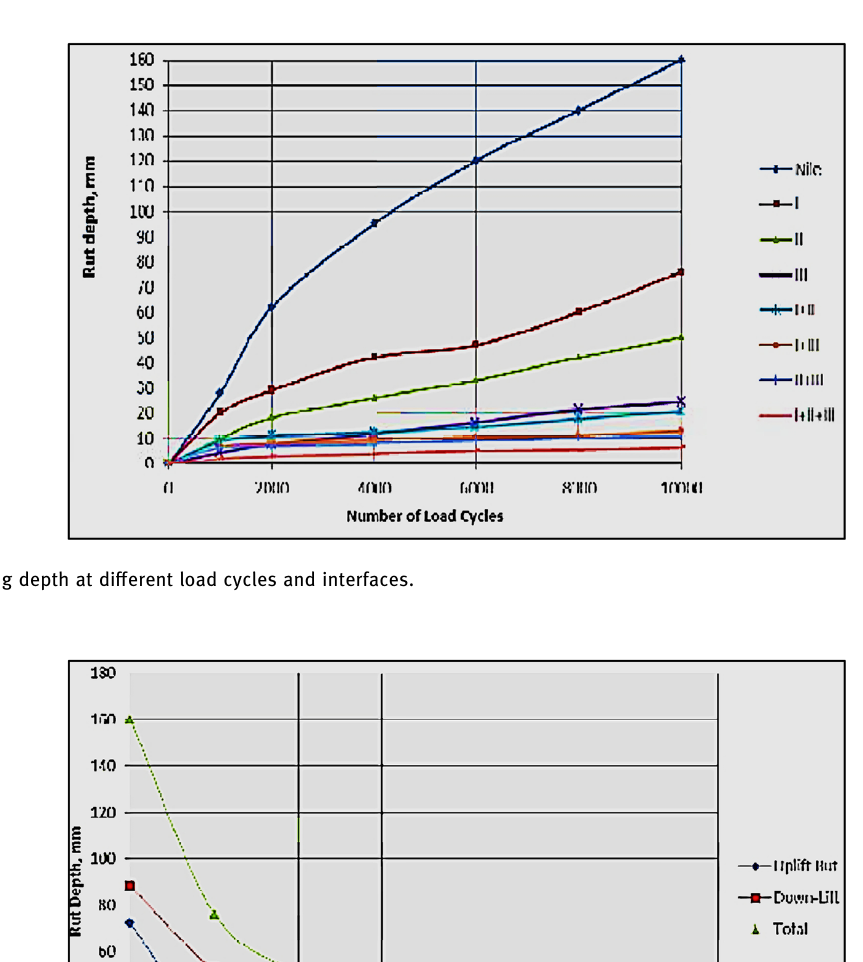
Figure 19: Rutting at the control section.